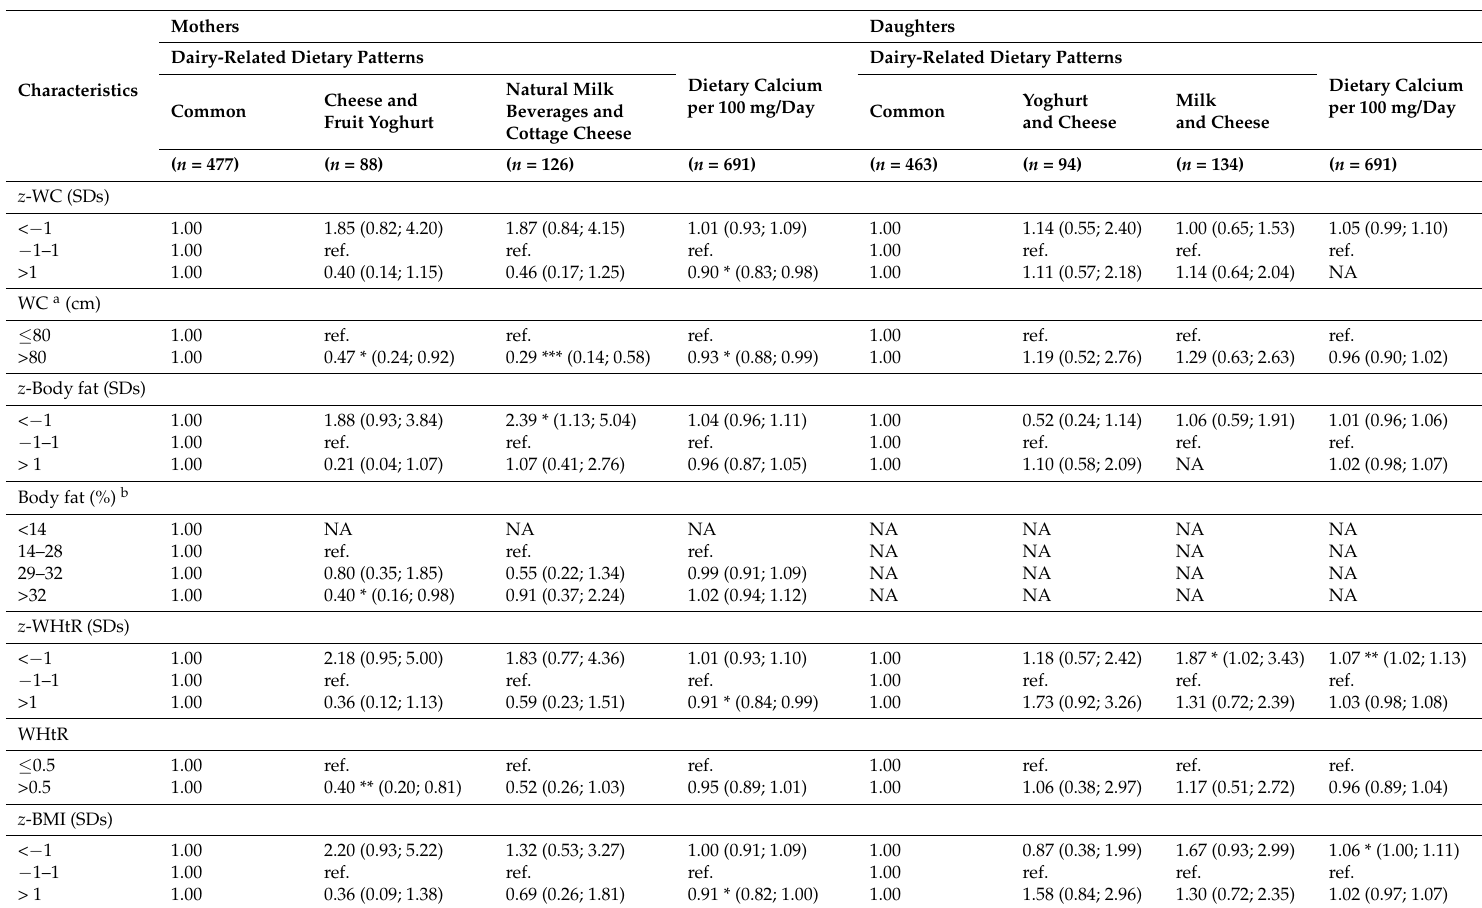
Table 4. Adjusted a odds ratio (95% confidence interval) of the prevalence of abnormal body weight and composition according to dairy-related dietary patterns and calcium